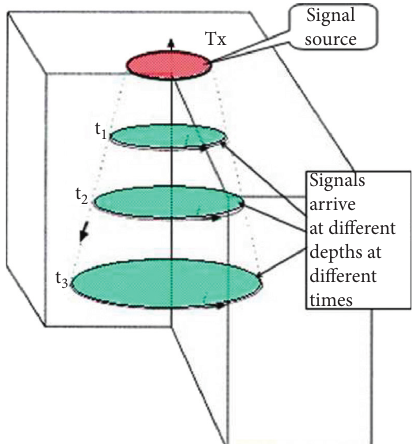
Figure 1: Schematic diagram of transient electromagnetic